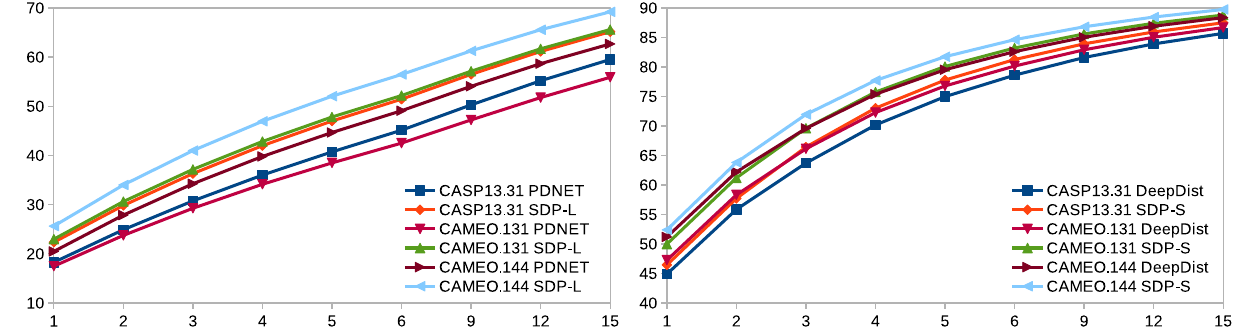
Figure 5. Percentages (y-axis) of residue pairs with actual distances below 36Å (left) and below 16Å (right) such that those residue pairs have predicted values with absolute errors below various given threshold limits (x-axis).